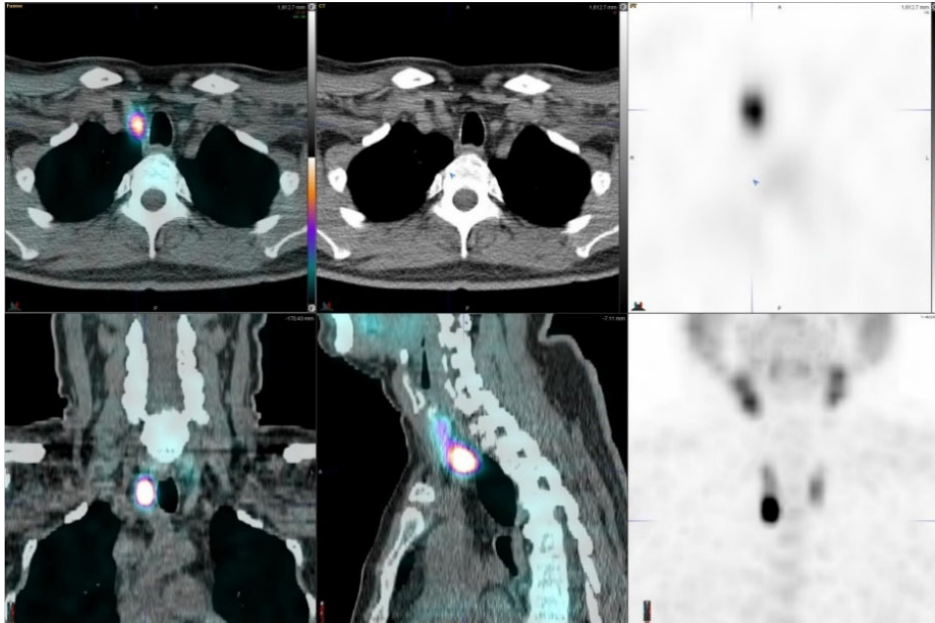
Figure 1. A 55 ‐ year ‐ old male with hyperparathyroidism, right inferior parathyroid adenoma, it Figure 1. A 55-year-old male with hyperparathyroidism, right inferior parathyroid adenoma, it weighed 2.4 g. His S-PTH weighed 2.4 g. His S ‐ PTH concentration was 162 ng/L and S ‐ Ca 10.9 μ g/L. The SUVmax values were concentration was 162 ng/L and S-Ca 10.9 µ g/L. The SUVmax values were 21.8 (CGZAS) and 16.7 (CGAS), respectively. 21.8 (CGZAS) and 16.7 (CGAS), respectively. Visually, this was a high uptake (TBR > 8) and the Visually, this was a high uptake (TBR > 8) and the lesion diameter on CT was 18 lesion diameter on CT was 18 mm.